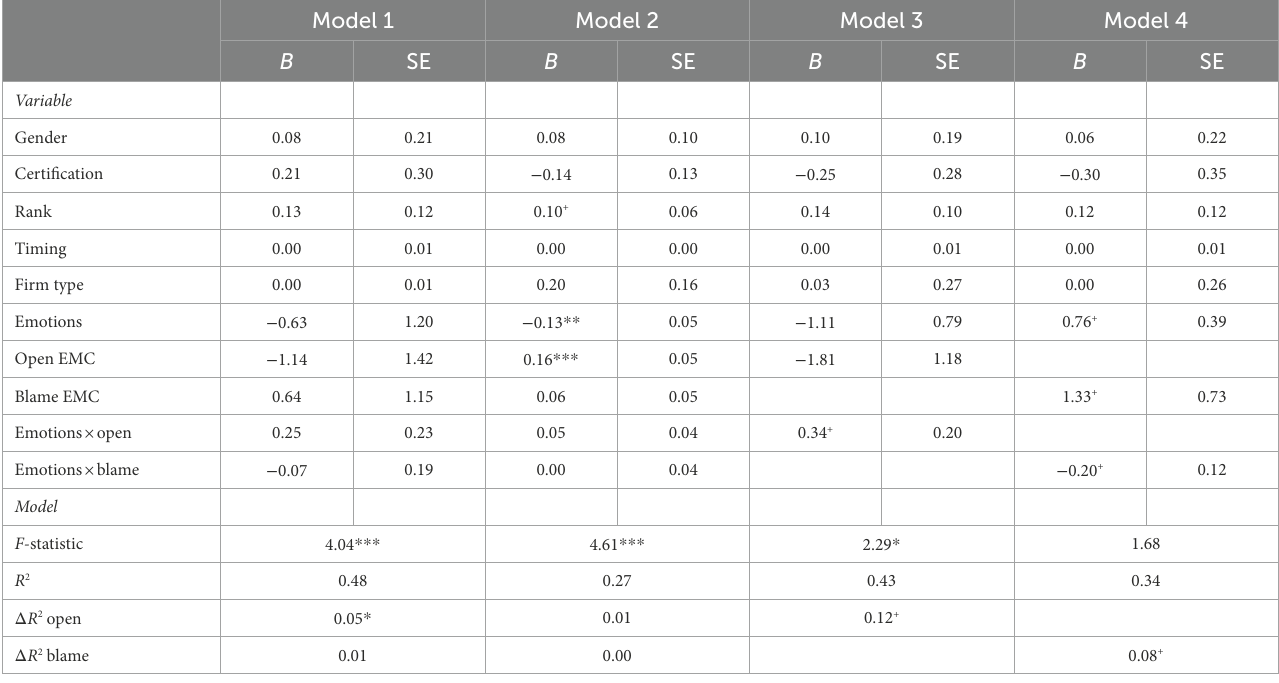
TABLE 3 Additional analyses of the emotions—error learning